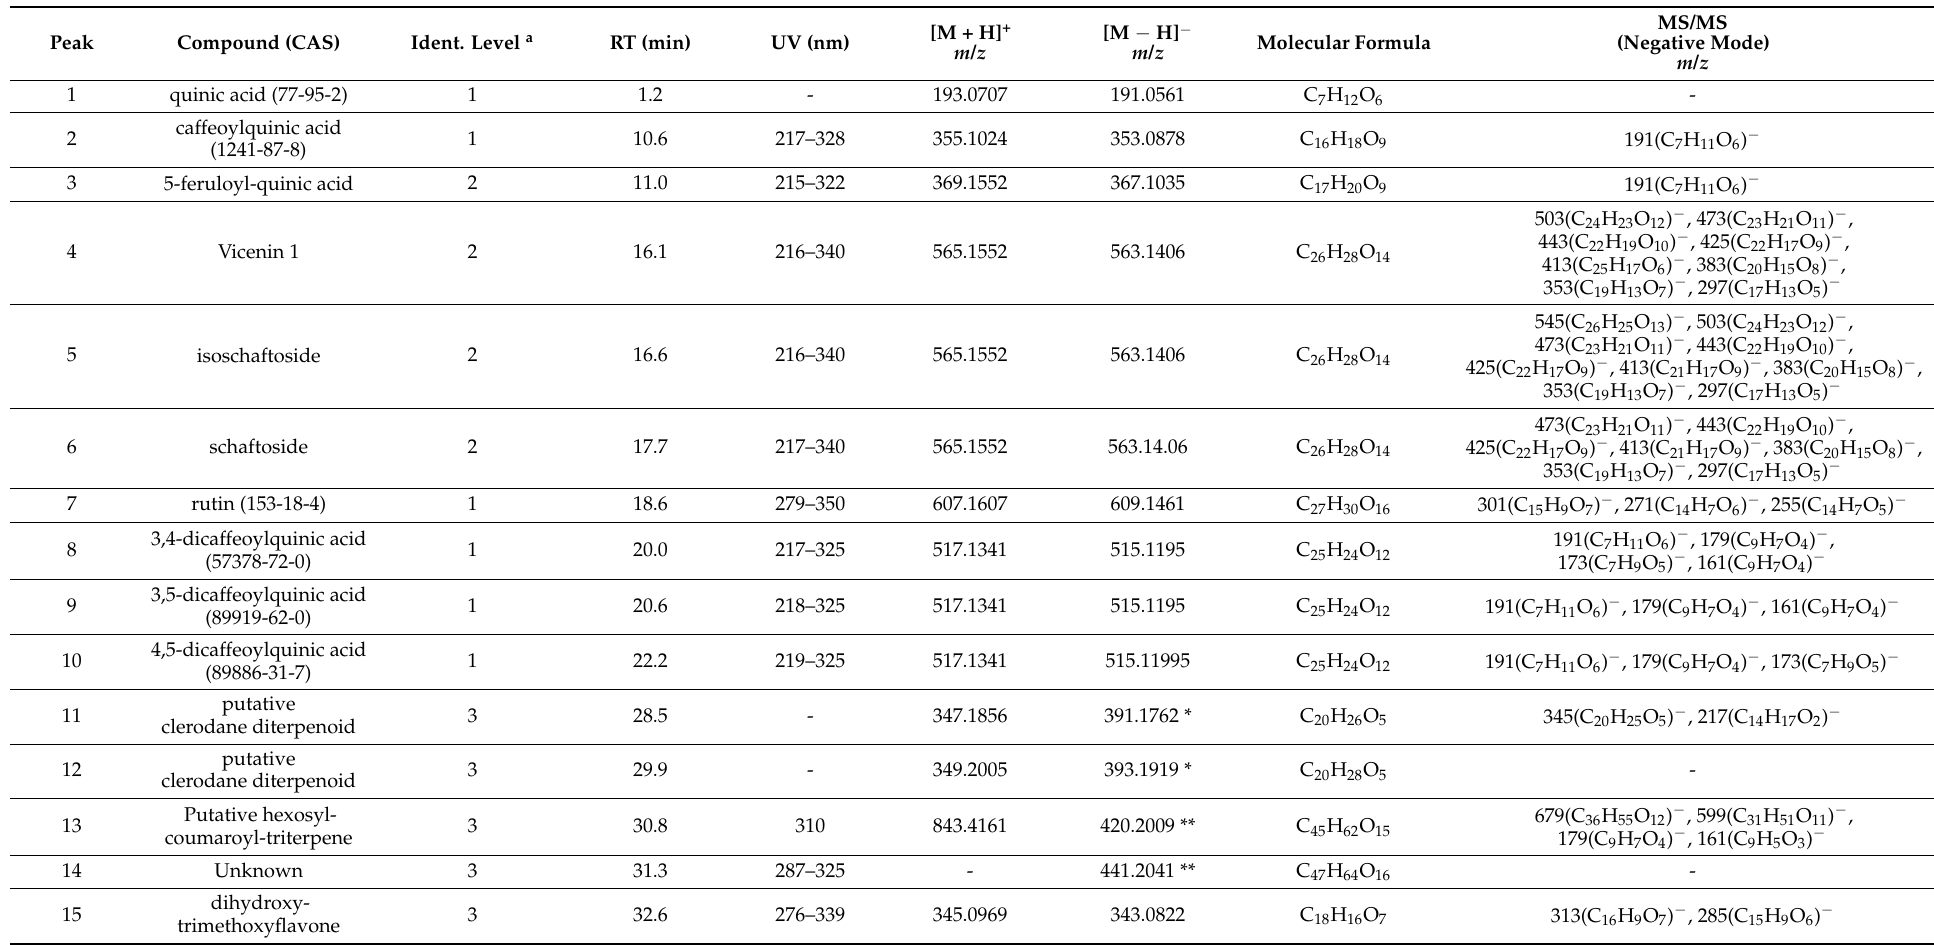
Table 1. Compounds identified by HPLC-DAD-MS/MS in the Baccharis trimera infusion